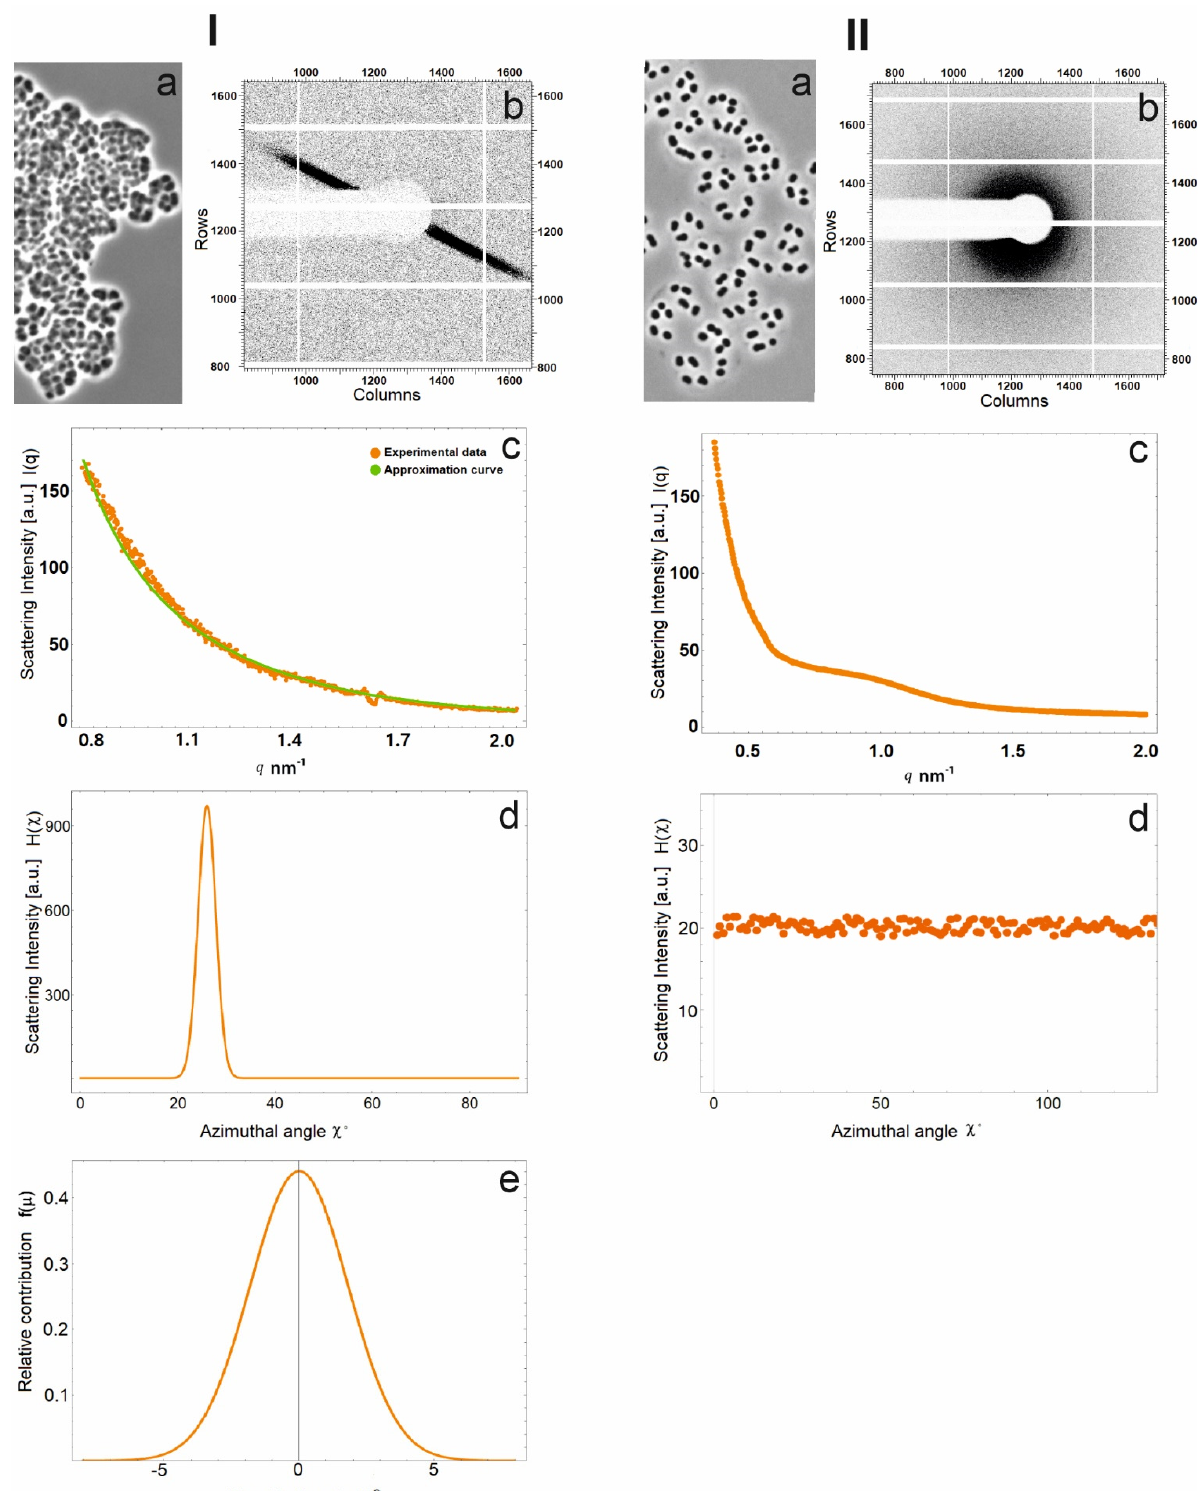
Figure 4. Scattering intensity from 45-day-old ( I ) and 14-day-old ( II ) cultures of Acidisarcina poly- morpha SBC82 T . ( a ) Phase-contrast images of bacterial samples. ( b ) 2-D scattering intensity of the samples. ( c ) Scattering intensity I(q r ) averaged along azimuthal angle χ . ( d ) Scattering intensity H( χ ) averaged along the radial component of scattered vector q. ( e ) Calculated probability distribution of individual fibril angel μ , zero-based at the cell axis.